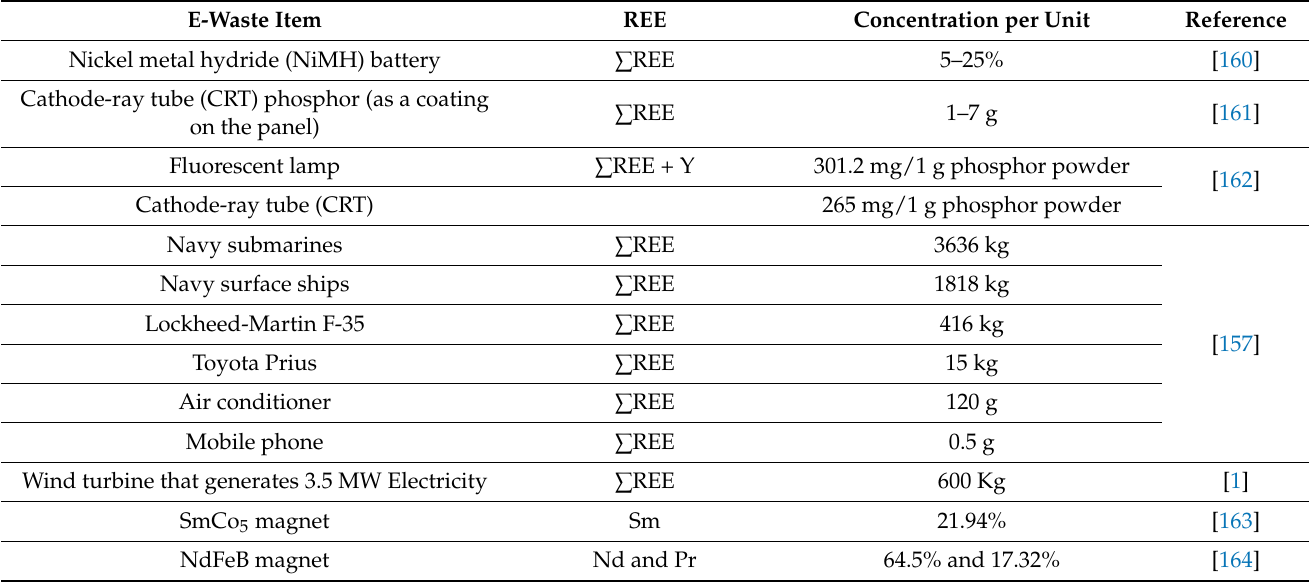
Table 8. Amounts of rare earth elements in different e-waste